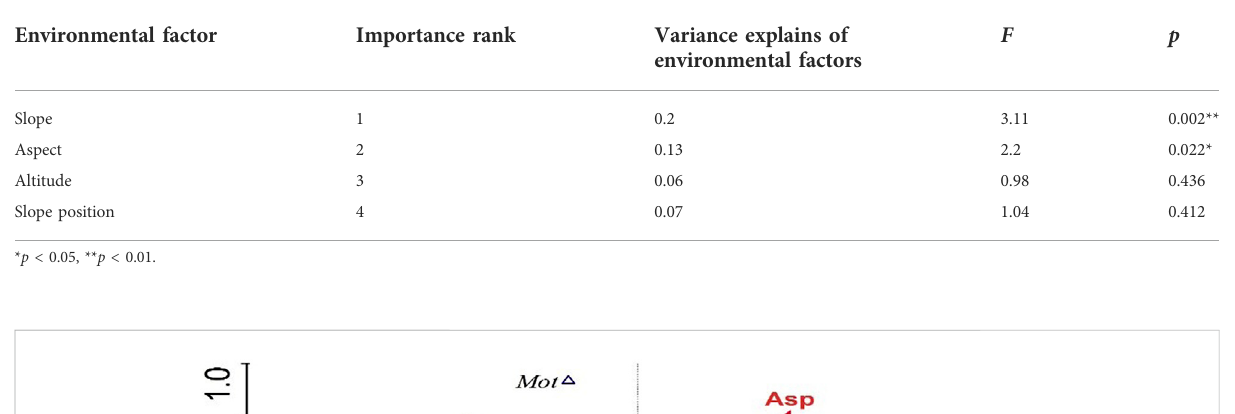
TABLE 4 Rank of importance and signi fi cance test of environmental factors.